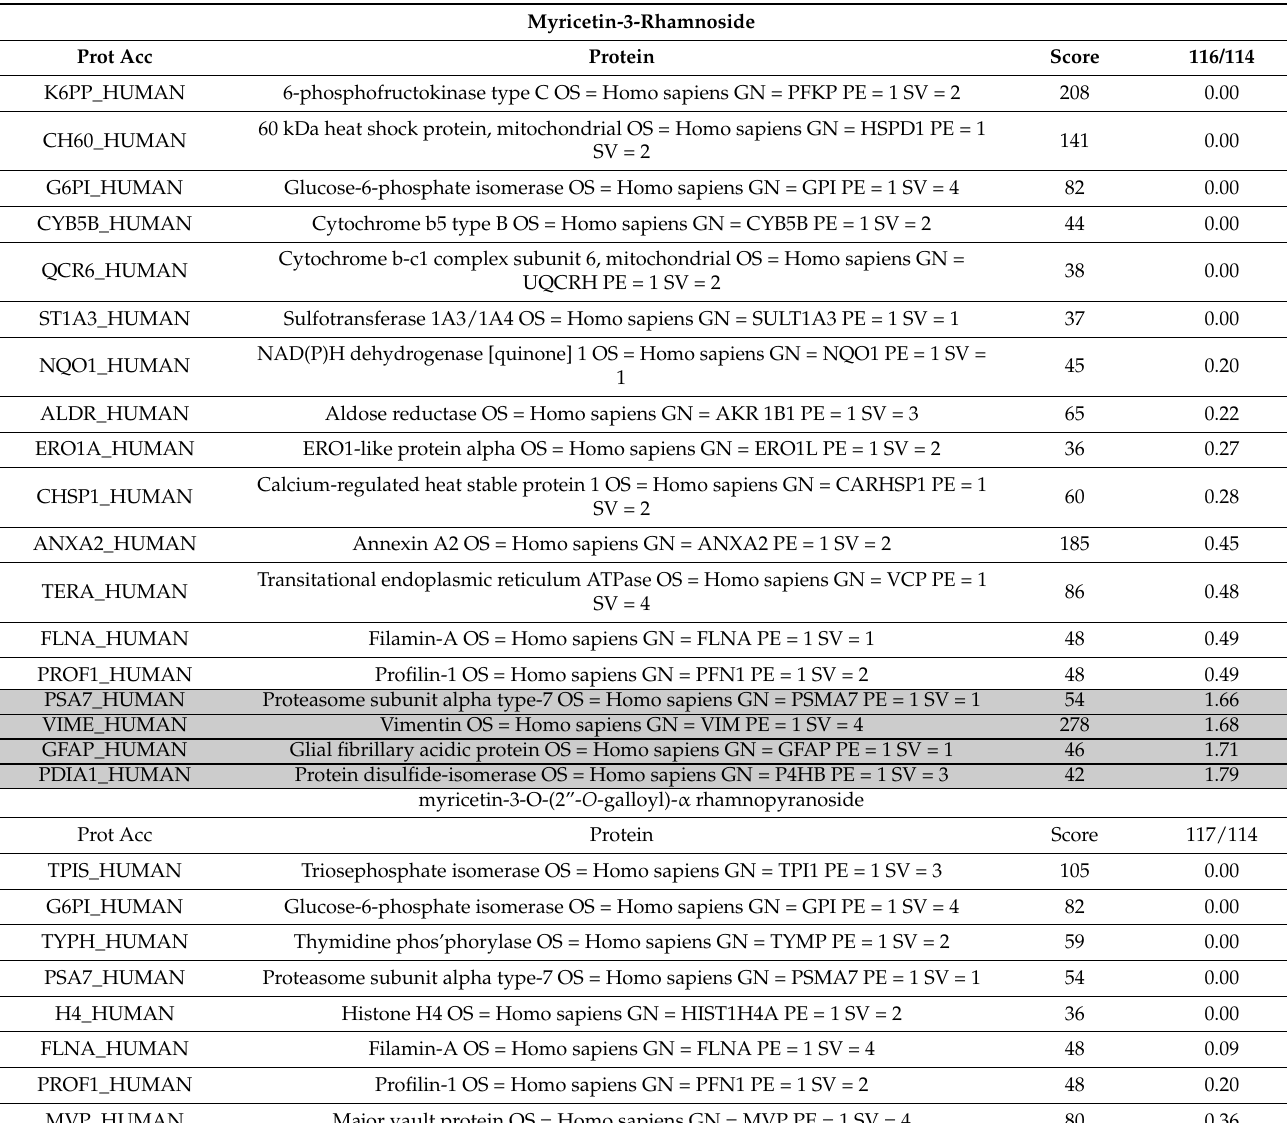
Table 4. Identification of proteins detected from HepG2 cells treated with flavonoid myricetin-3- rhamnoside and myricetin-3-O-(2”- O -galloyl)- α rhamnopyranoside with a score ≥ 30. Myricetin-3-Rhamnoside Prot Acc Protein Score 116/114 6-phosphofructokinase type C OS = Homo sapiens GN = PFKP PE = 1 SV =